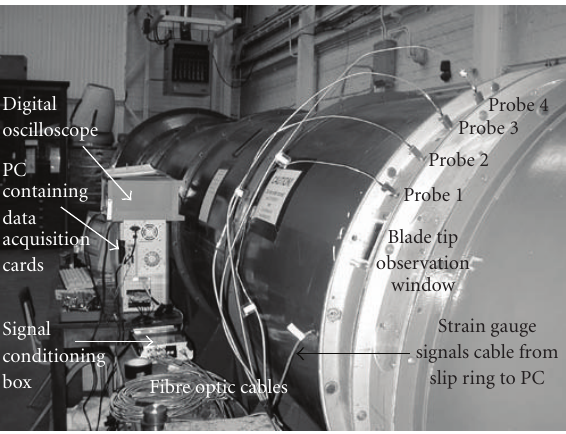
Figure 2: External view of the BTT experimental